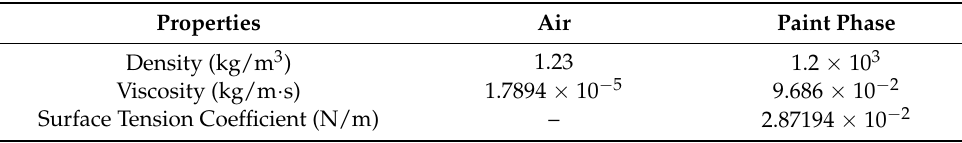
Table 1. The properties of the materials in numerical